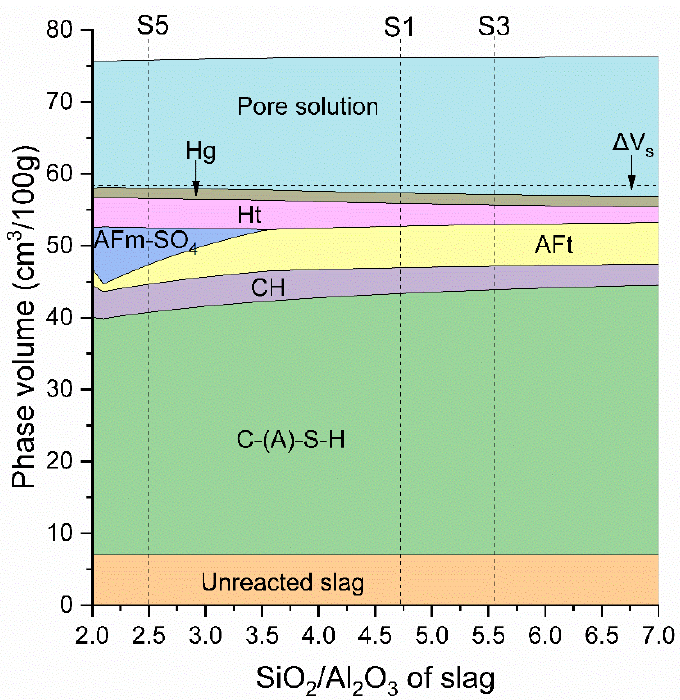
Figure 19. Modelled phase volume changes of slag blended paste with the effect of S/A ratio in slag.